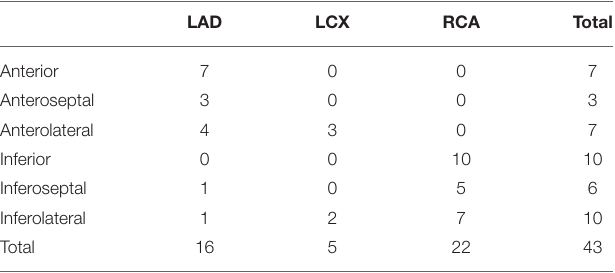
TABLE 4 | CTO vessels and the distribution of wall motion abnormalities.